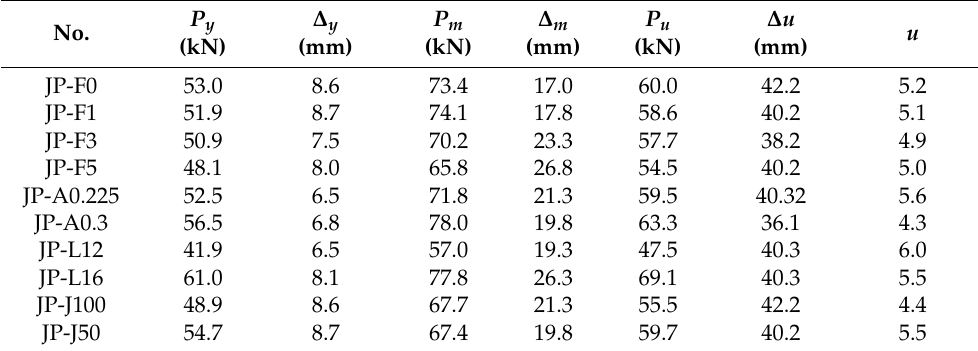
yield load of the specimens decrease due to the increase in the yield displacement, and the increase in the peak displacement would affect the ultimate displacement at the same time due to the yield displacement and ultimate displacement in the same change trend, leading to no obvious change in the test displacement ductility coefficient. Table 6. The characteristic values and the ductility coefficient. ∆ ∆ ∆ u P y P m P u y m No. (kN) (mm) (kN) (mm) (kN) (mm)